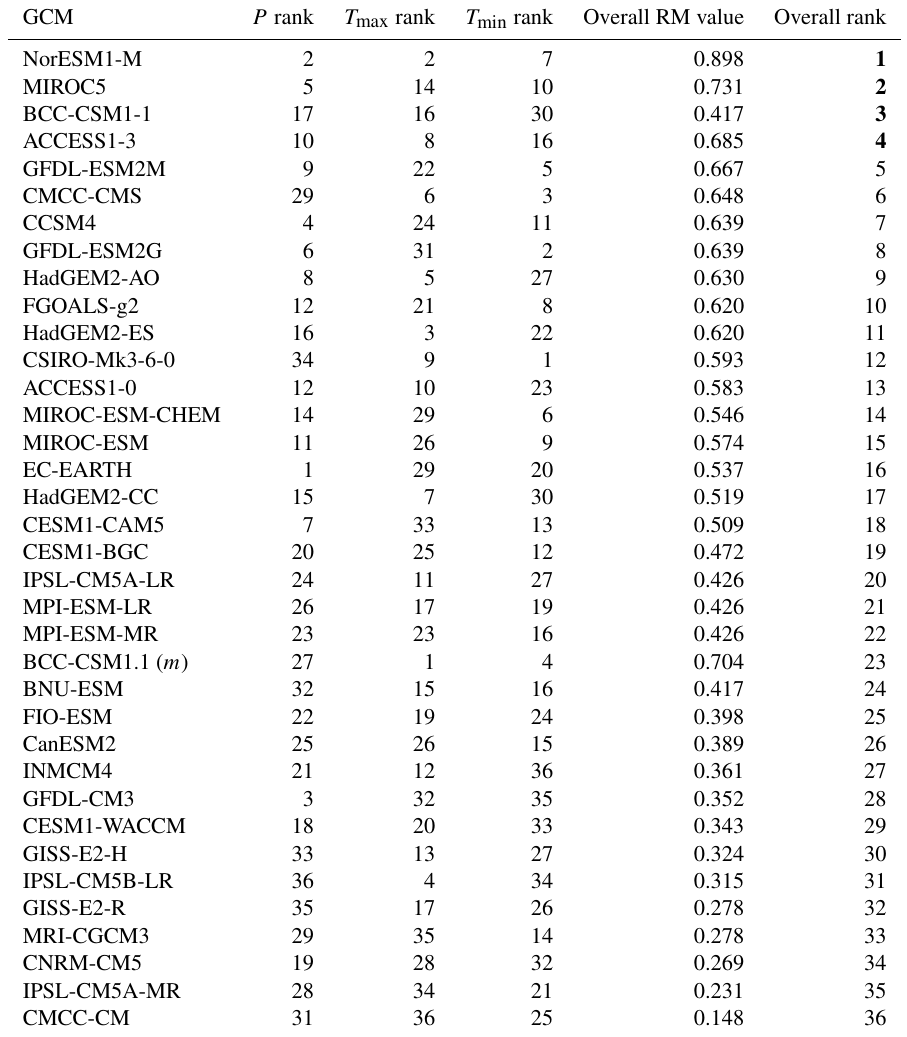
Table 5. Overall ranks of GCMs for the identification of ensemble members. Bold numbers represent the selected